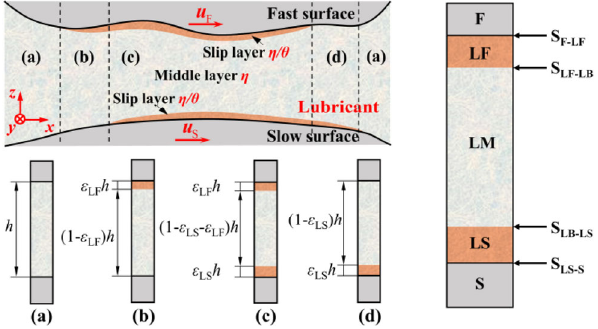
Fig. 27 Layered slip model proposed by Zhang et al. Reproduced with permission from Ref. [606]. © Elsevier,